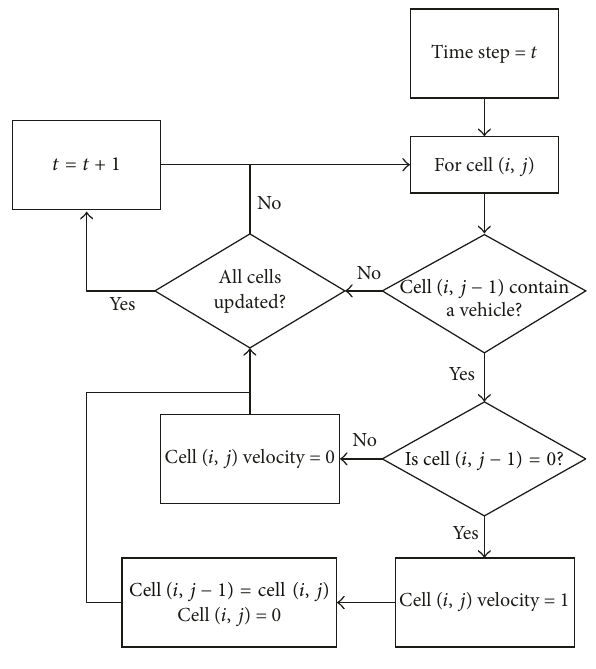
Figure 3: Algorithm for forward motion.